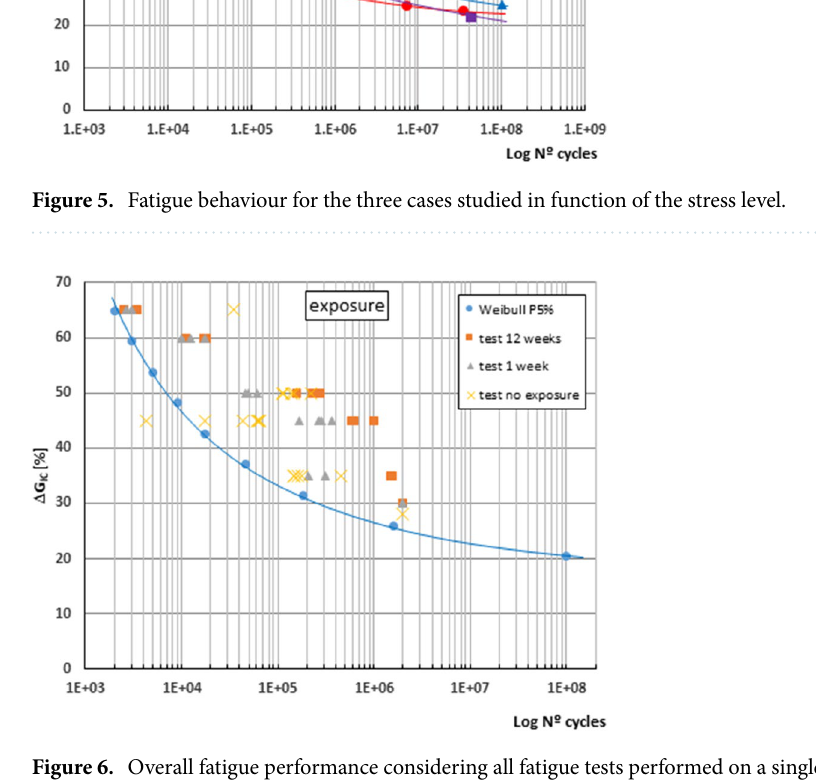
Figure 6. Overall fatigue performance considering all fatigue tests performed on a single